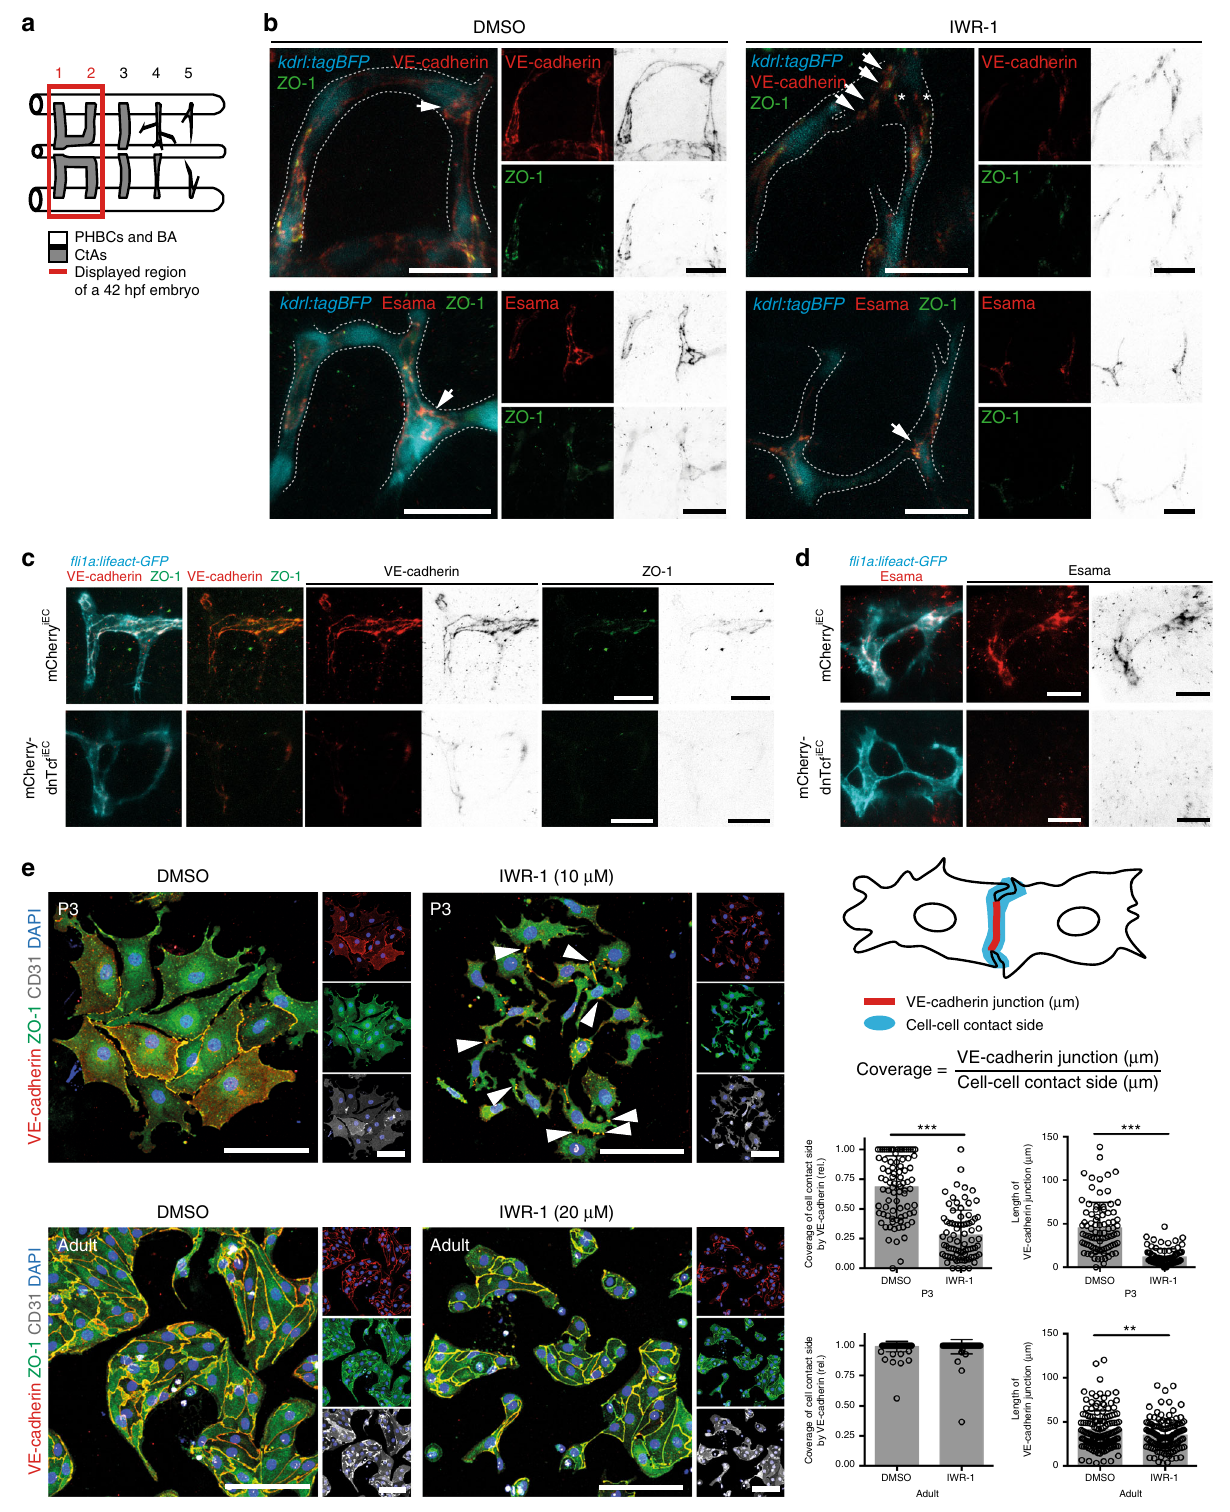
To test the effects of S1pr inhibition on lumen formation and VE-cadherin localization, we next applied the antagonists of S1pr signaling during CtA angiogenesis at 29 hpf and assessed patterning and lumen formation at 48 hpf. In contrast to barriergenesis, treatment during brain angiogenesis with either VPC or TY did not affect CtA development and lumen formation in zebra fi sh (Fig. 5a). It is therefore likely that in wild-type